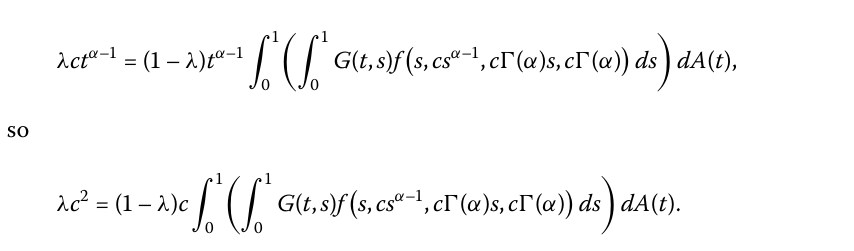
we figure out J : Im ( Q ) → Ker ( L ) is a linear isomorphism operator given by J ( c ) = ct α – . , then u ( t ) = ct α – For every u ( t ) ∈ (cid:6) () 